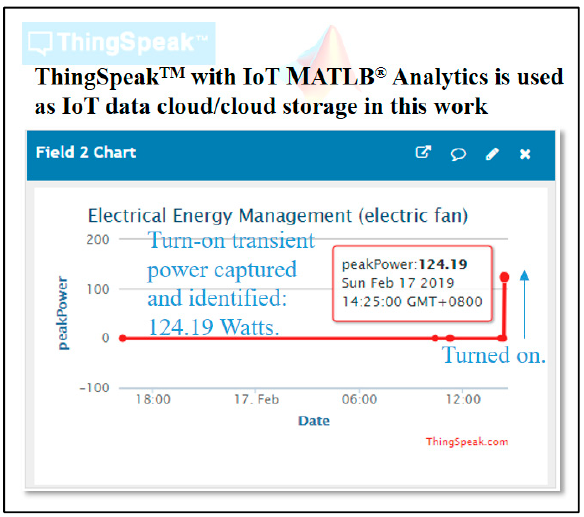
Figure 9. Data visualization by the open ThingSpeak TM IoT platform for electrical energy management in this experimentation. The turn-on transient power, peakPower, consumed by an electric fan and identified by the presented AI-embedded and Arduino MCU-based smart power meter prototype, was 124.19 W.